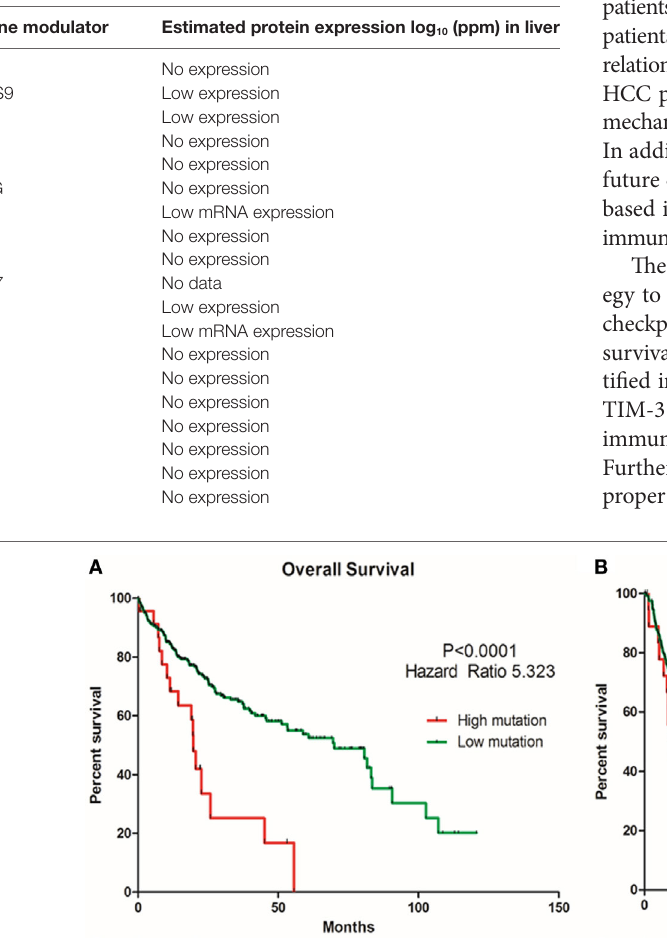
TaBle 2 | Estimated protein expression in normal